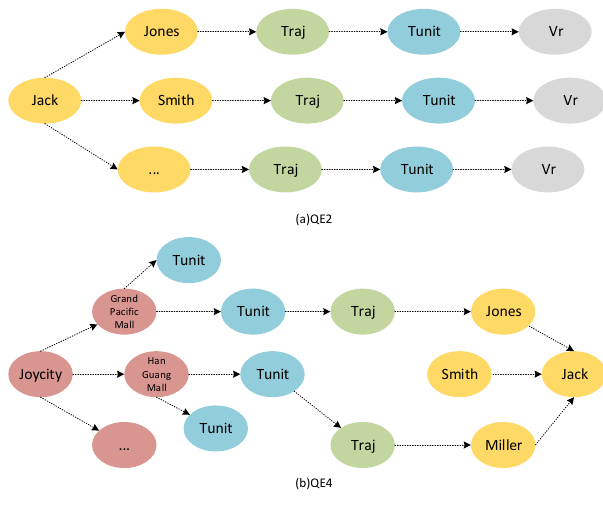
Figure 9. Schematic of queries supported with the GSM